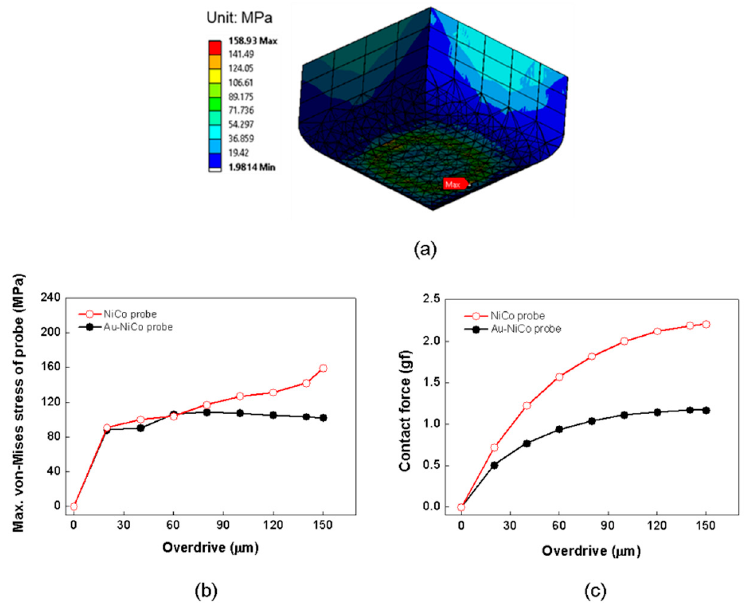
Figure 6. ( a ) The von Mises stress distribution map of the NiCo probe tip area during contact with a solder ball. ( b ) The variation in the maximum stress of the NiCo and Au–NiCo probes with increasing overdrive. ( c ) The variation in the probe contact forces with increasing overdrive.